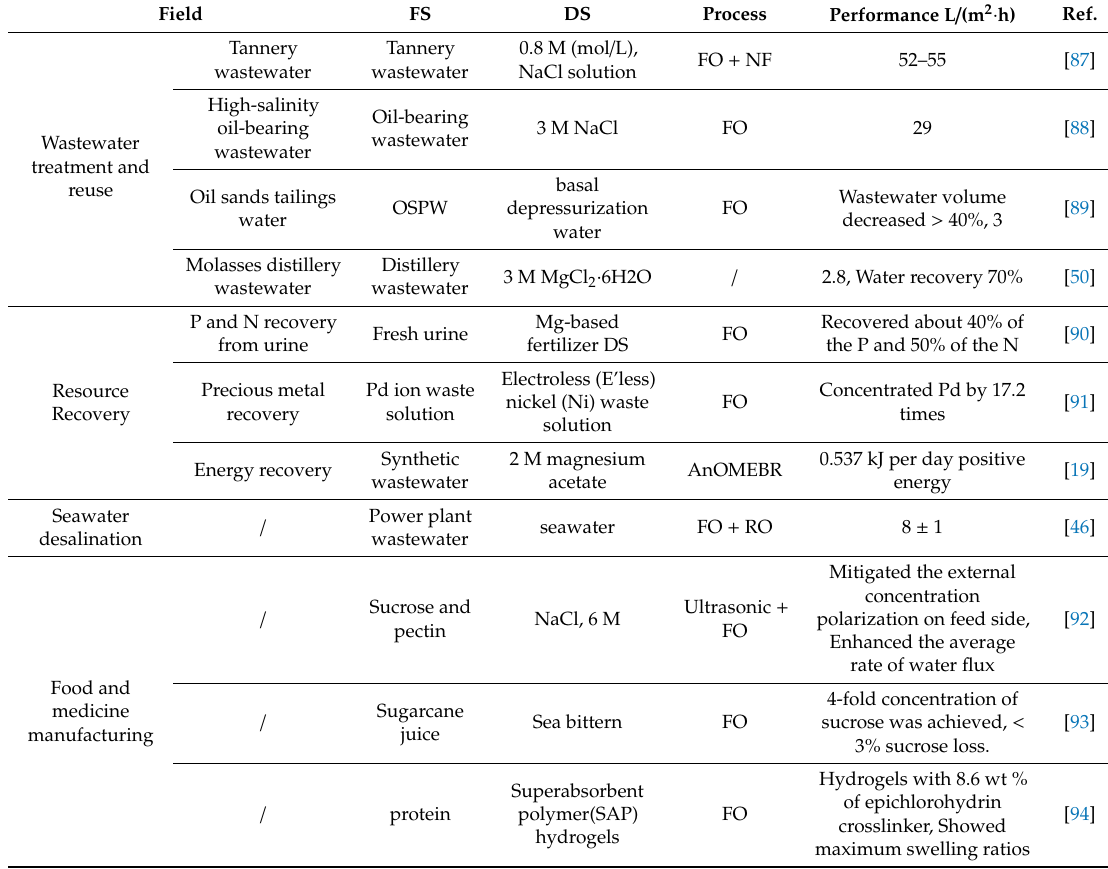
Table 3. List of the application of FO in di ff erent